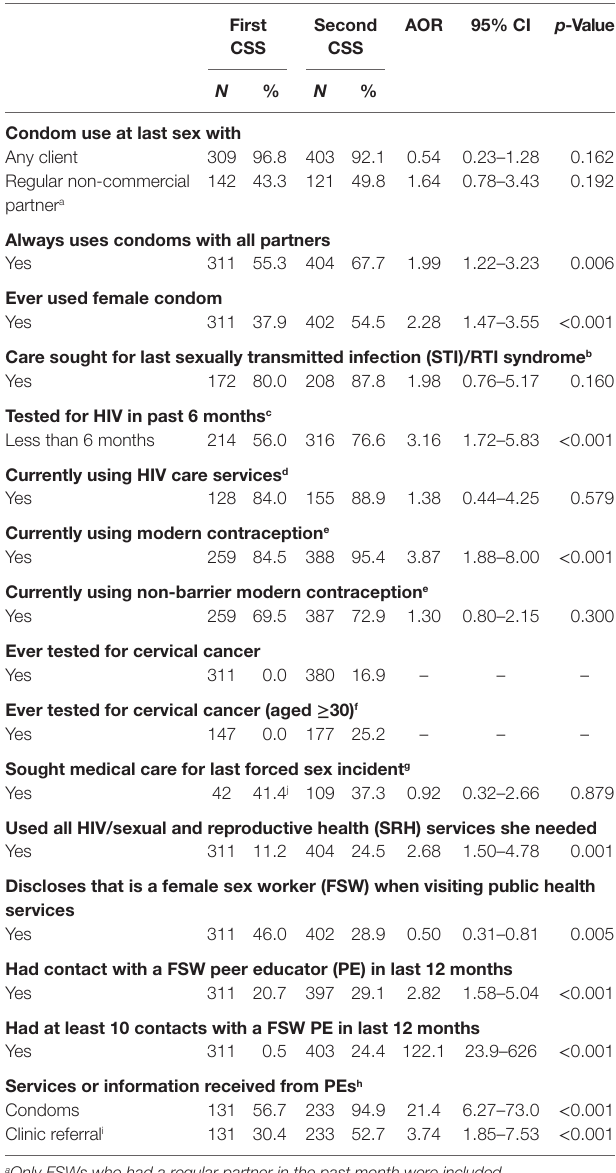
TaBle 3 | Use of sexual and reproductive health commodities and services by female sex